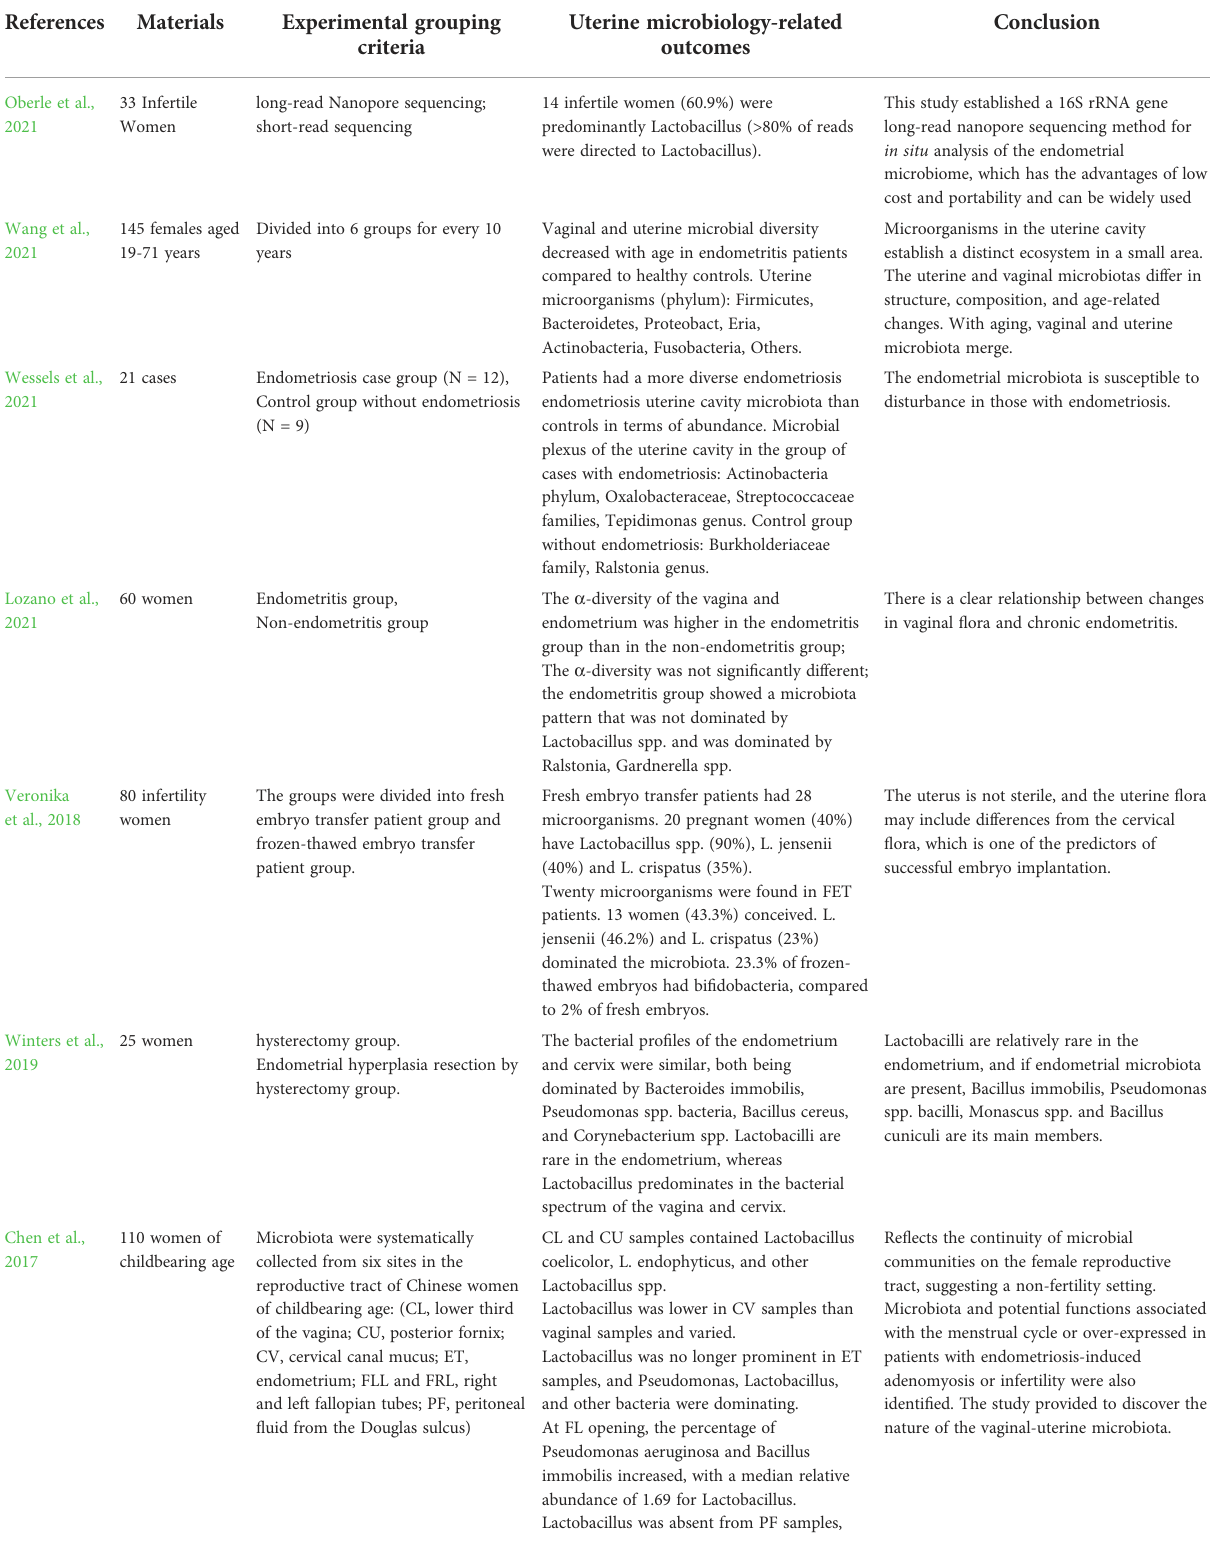
TABLE 2 Recent advances in research on the microbial composition of the